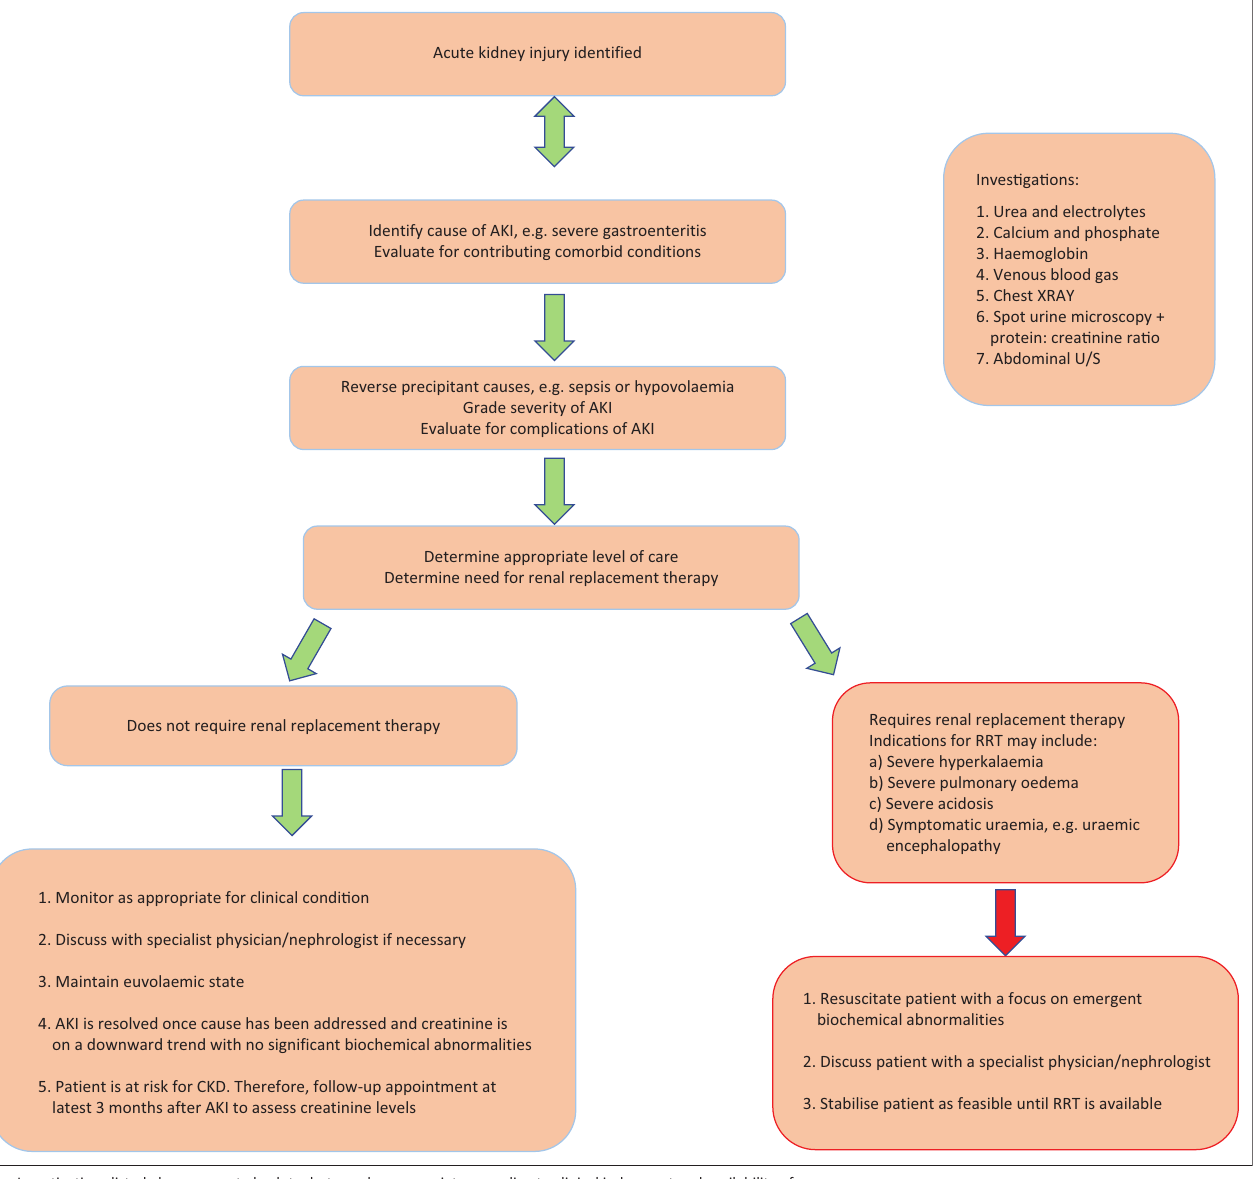
FIGURE 2: Algorithm for management of acute kidney injury, based on the KDIGO 2012 acute kidney injury